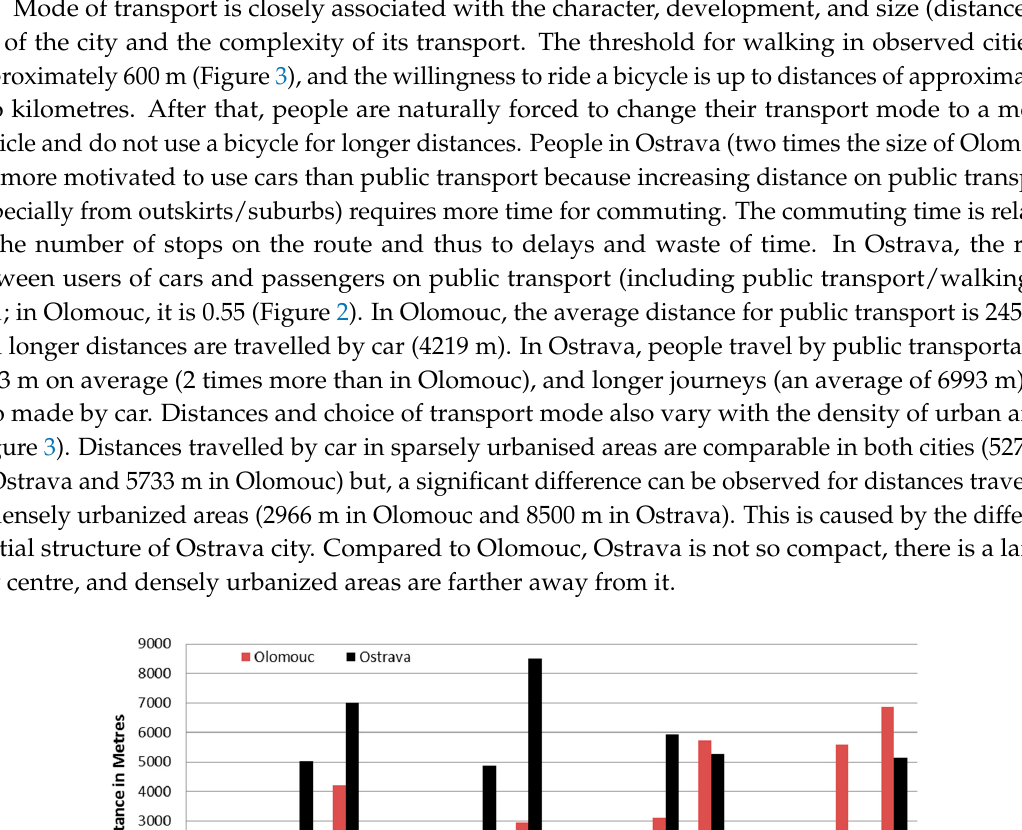
Figure 2. Structure of routes by means of transport in Olomouc and Ostrava.